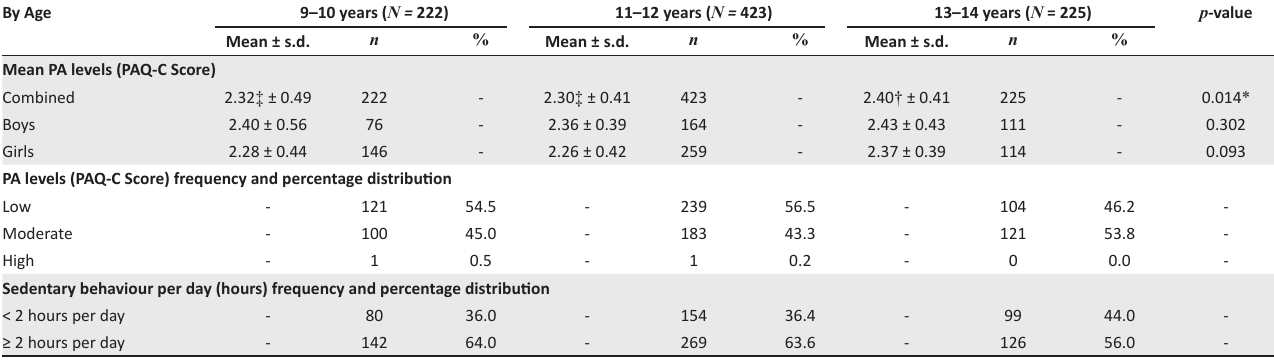
TABLE 1b: Summary levels, frequencies and percentages of physical activity (PA) and sedentary behaviour classifications by age. By Age